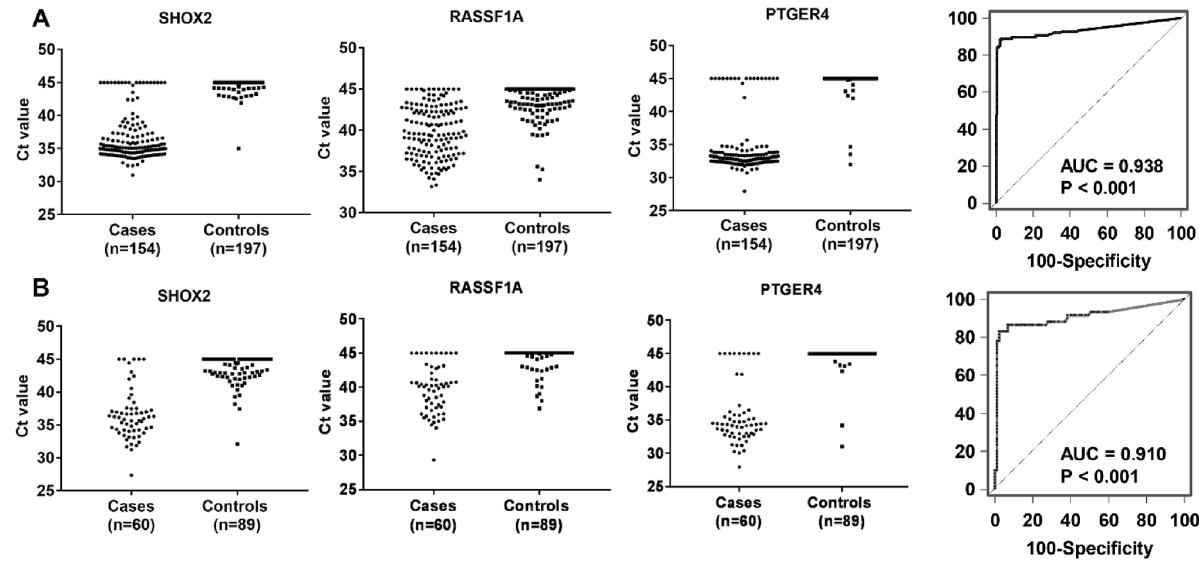
Figure 3. The methylation level distribution of short stature homeobox 2 gene ( SHOX2 ), ras association domain family 1A gene ( RASSF1A ), and prostaglandin E receptor 4 gene ( PTGER4 ) and diagnostic accuracy (ROC analysis) of the three gene methylation panel in the training cohort ( A ) and validation cohort ( B ).